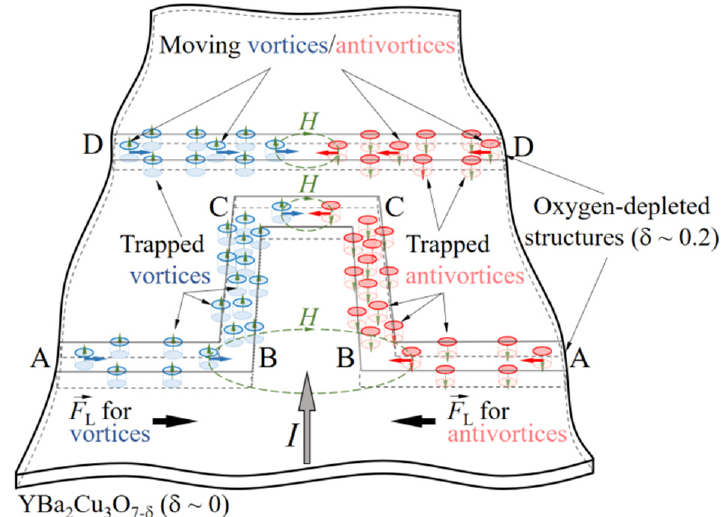
Figure 4. Vortices/antivortices motion scheme, demonstrating that the BC segments are oriented perpendicularly to the Lorentz force, which creates the edge effect pinning for vortices/antivortices there. If the Lorentz force exceeds the pinning force, the level of energy dissipation increases due to the onset of vortex motion in the CC segment of sample 2. When the vortices/antivortices stopped moving, the level of energy dissipation